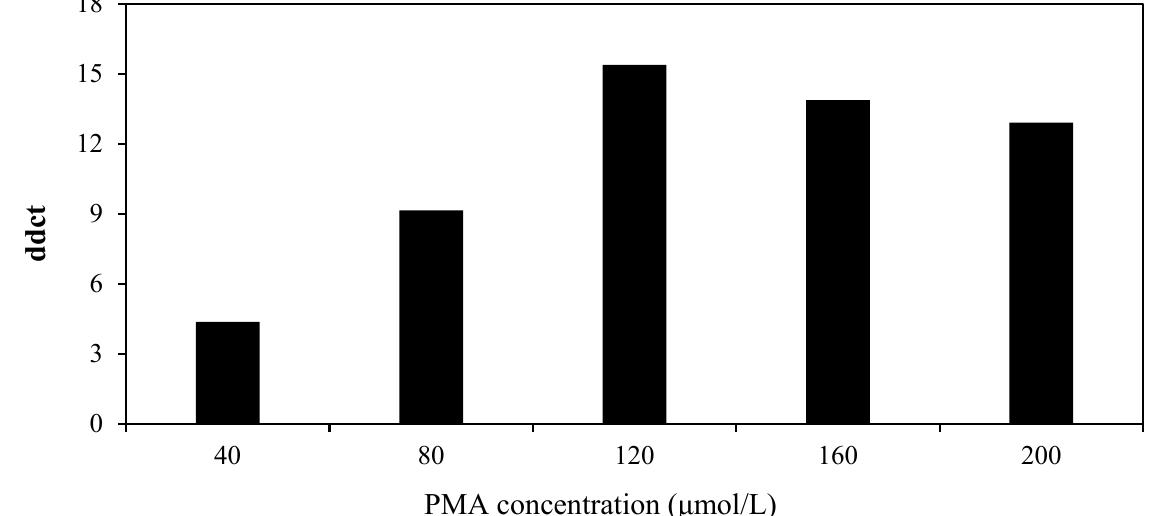
Figure 3. Effect of PMA concentration on the amplification of RNA from infectious and inactive CGMMV. Infectious and inactive CGMMV virus suspensions were exposed to different concentrations of PMA (0, 40, 80, 120, 160 and 200 µ mol · L − 1 ). ddCt = dCt (inactive) − dCt (infectious); dCt = Ct (+PMA) − Ct ( − PMA).